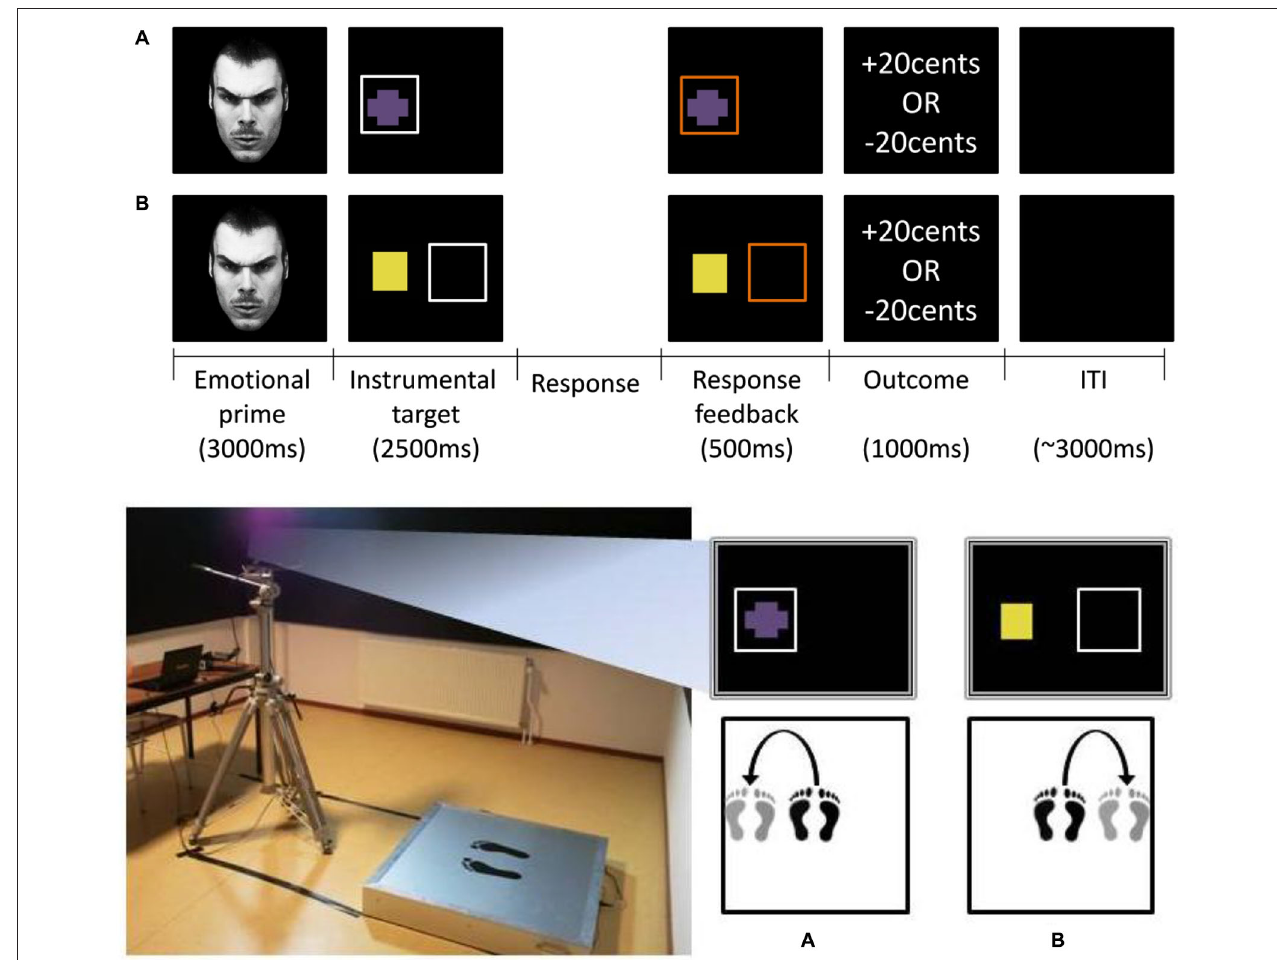
duration of the intertrial interval was 3000 ms on average. Bottom panel : Balance board apparatus (left) and examples of a go-response (right) in (A) the approach block and (B) the avoidance block. Approach-go: sideway step on the balance board towards the side of the instrumental target (A) . Avoidance-go: sideway step on the balance board away from the side of the instrumental target (B) . Approach-/avoidance- nogo-responses involved remaining stationary at the center of the balance